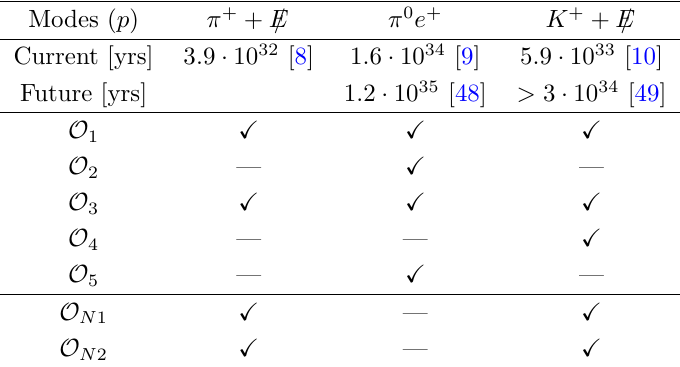
invariant under SM gauge transformations and B (cid:0) L , see e.g., refs. [43{46]